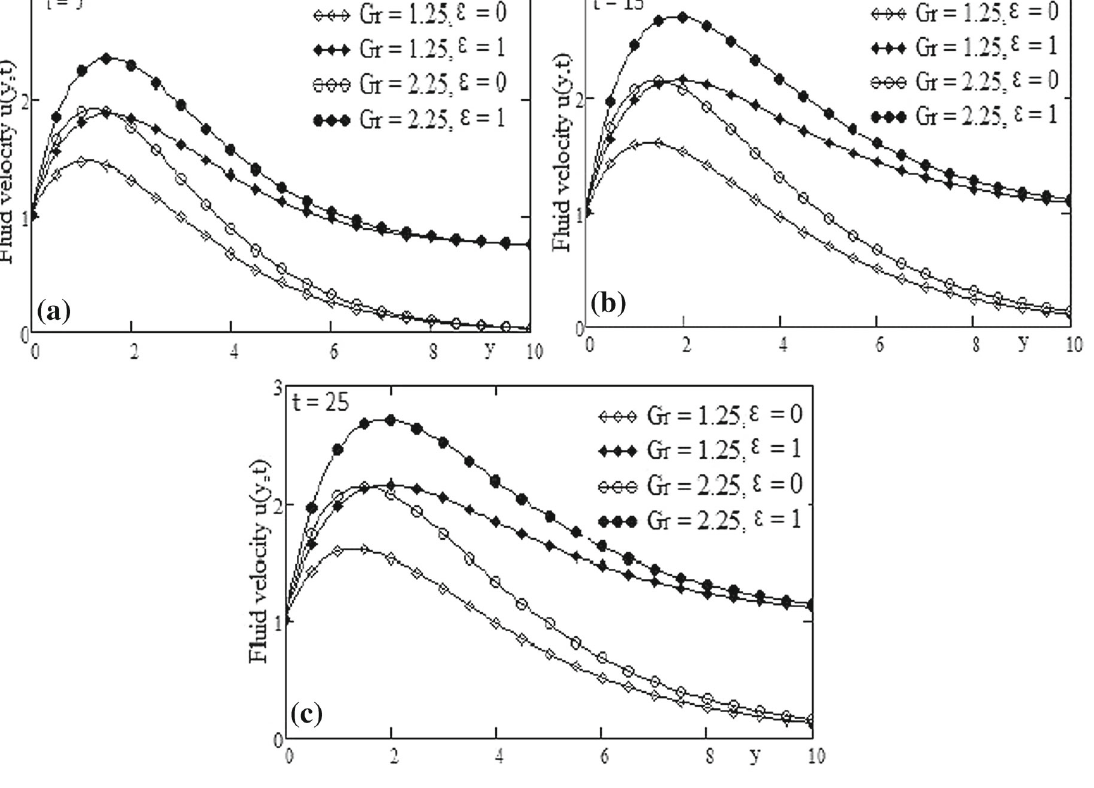
Fig. 2 Profiles of the dimensionless velocity given by Eq. (25) for Pr = 0 . 71, Q = 0 . 6, Sc = 0 . 2, R = 0 . 7, M = 0 . 25, Gm = 0 . 5, Gr = 1 . 25 and 2 . 25 and different values of time